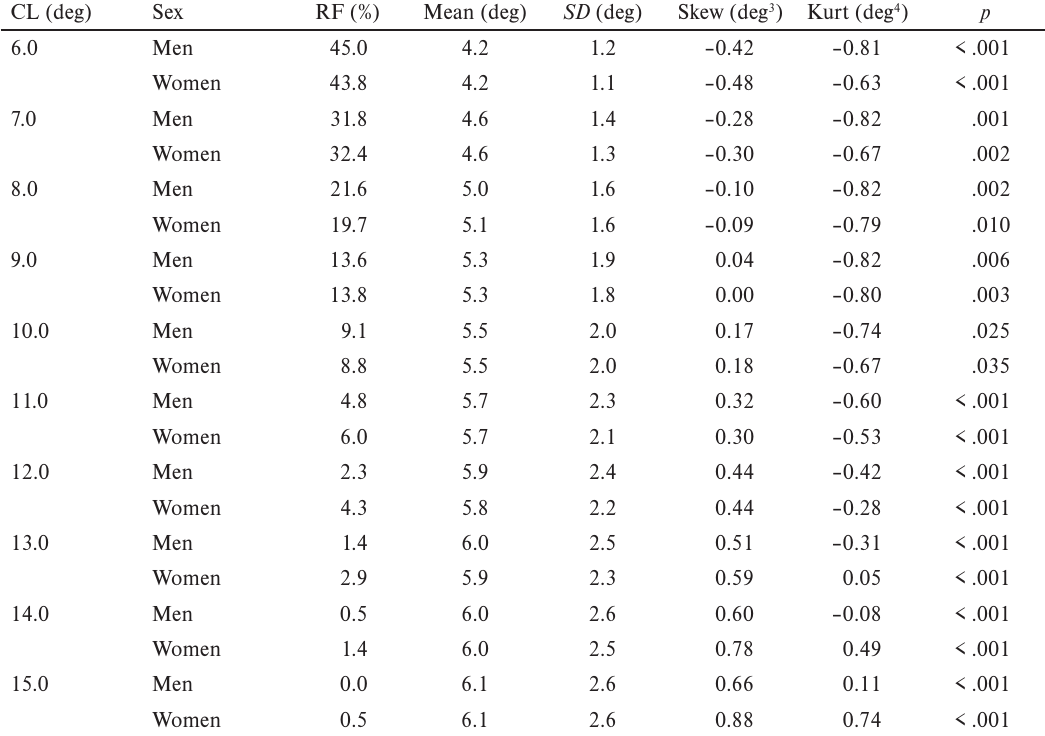
Statistics of lateral deviation in subgroup truncated by means of cut-off level for lateral deviation CL